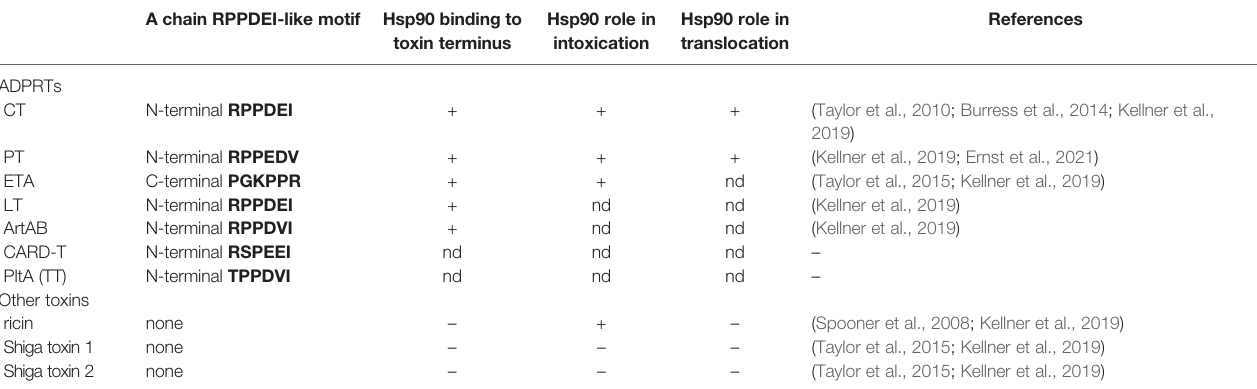
TABLE 1 | An RPPDEI-like motif at the termini of ER-translocating ADPRTs. A chain RPPDEI-like motif Hsp90 binding to